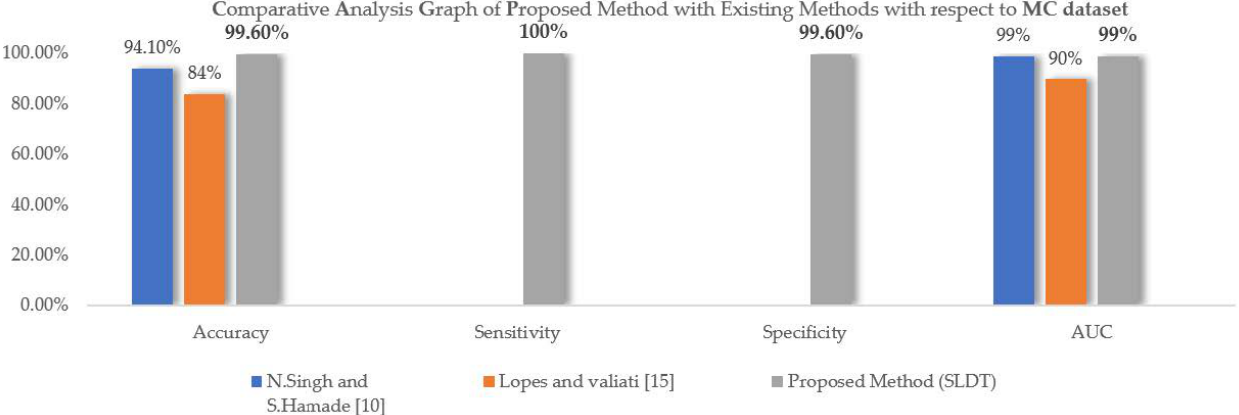
Figure 8. Comparative analysis graph of the proposed method with the existing method with respect to the MC dataset.